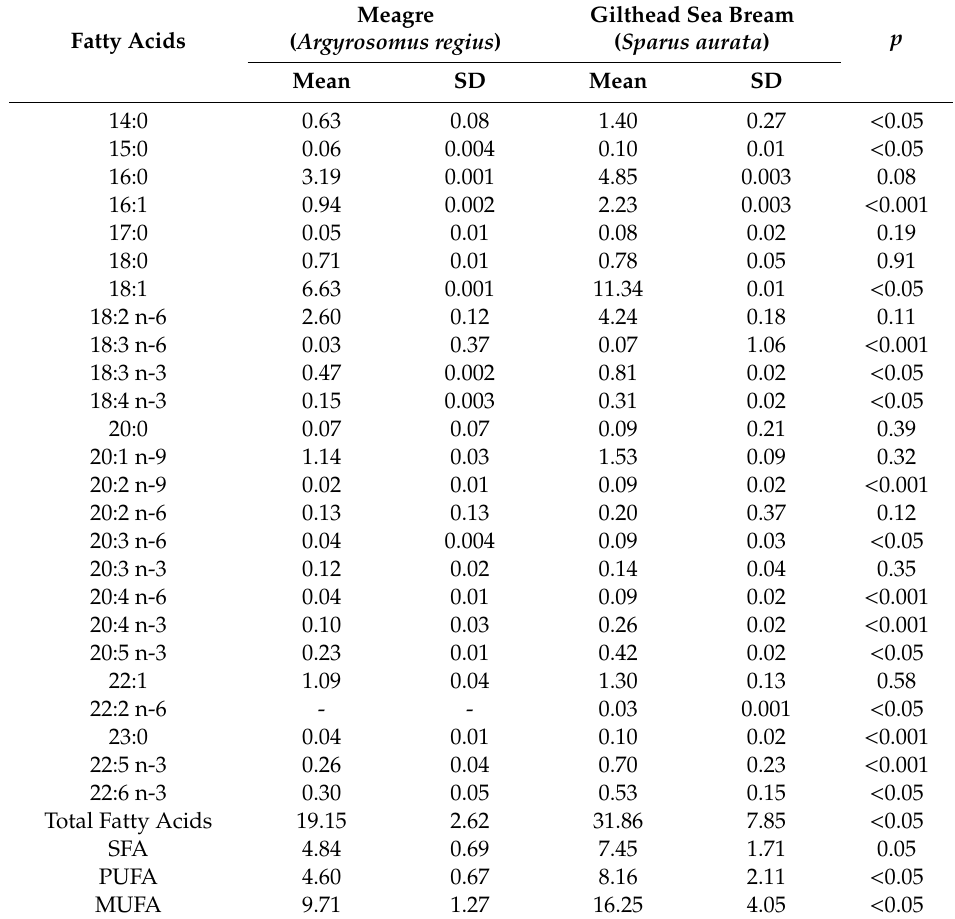
Table 4. Fatty acid content (g / 100 g) of the pooled by-products from meagre and gilthead sea bream